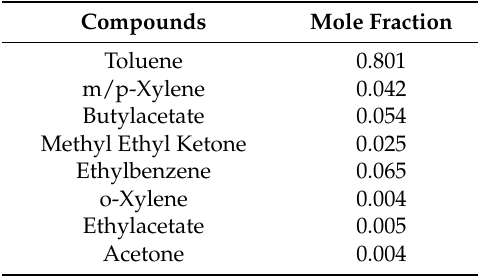
Table 1. Substance analysis results of paint for the experiment.